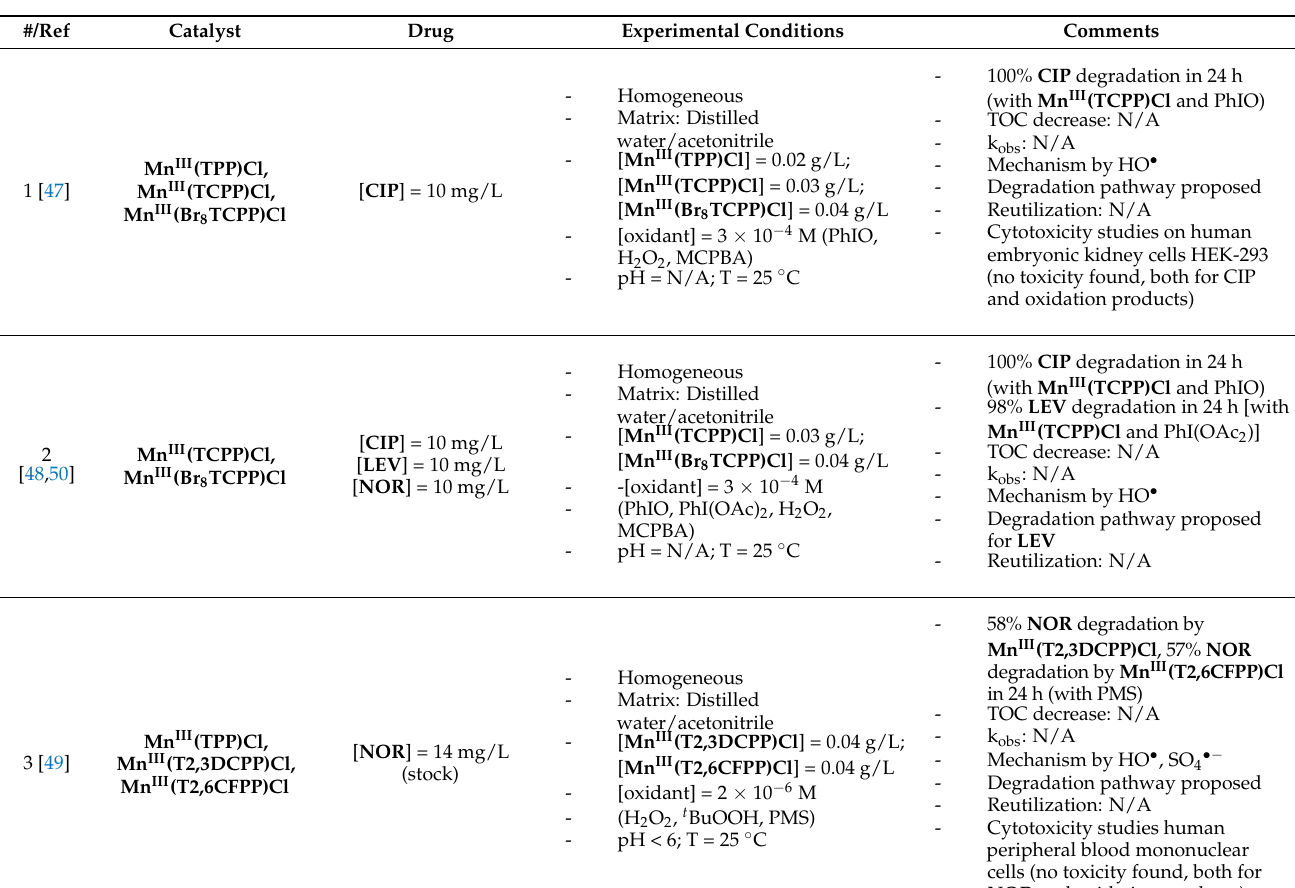
Table 2. Oxidative degradation of antibiotics using TPM-based